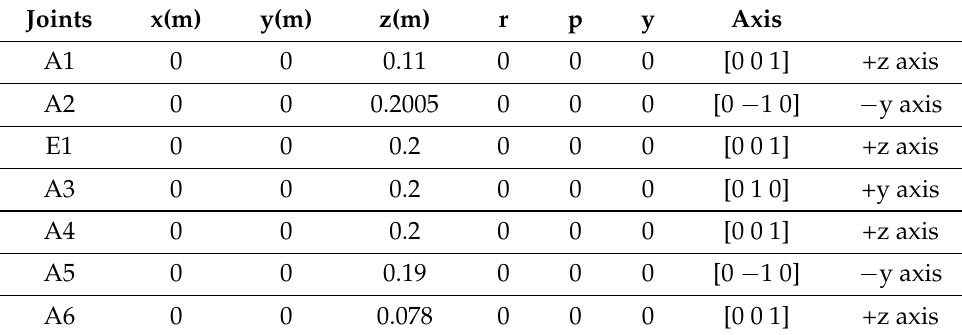
Table 2. URDF description of KUKA LWR 4+ robot.